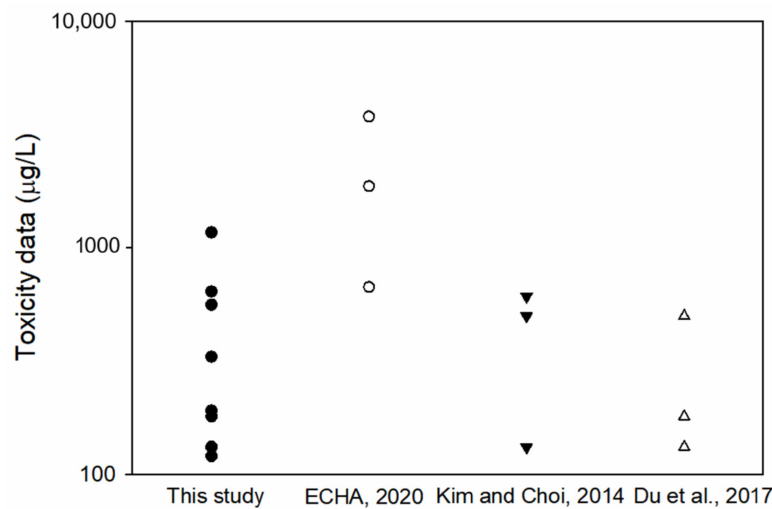
Figure 4. Toxicity data used for the derivation of predicted no-effect concentration (PNEC) of benzophenone-3 in this and three earlier studies (ECHA, 2020 [18]; Kim and Choi, 2014 [4]; and Du et al., 2017